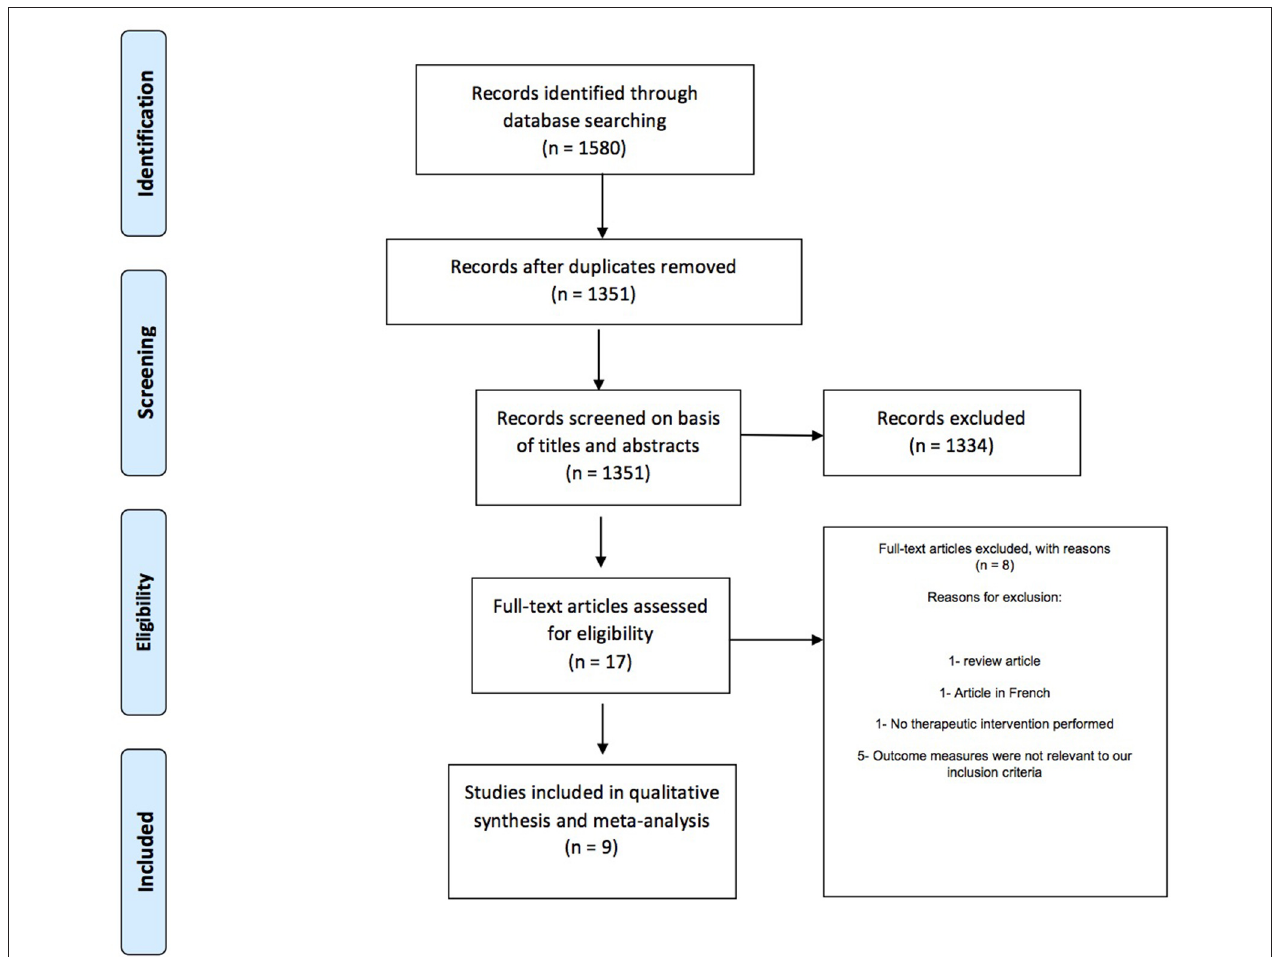
FIGURE 1 | PRISMA flowchart showing study screening and selection